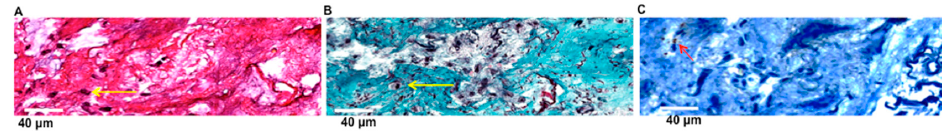
Figure 5. Cell distribution and apoptosis after 10 days of culture. ( A , B ) Haematoxylin-eosin-saffron (HES) and Masson’s trichrome staining of paraffin-embedded cellularized HEMOCOLLAGENE ® cross-sections, respectively. HES staining showing nuclei in blue (yellow arrow) and collagen in orange. Masson’s trichrome staining, showing collagen in green and nuclei in brown (yellow arrow); and ( C ) cleaved caspase-3 immunohistochemistry showing few apoptotic cells (red arrow) within HEMOCOLLAGENE ® . (Scale bars indicate 40 μ m).